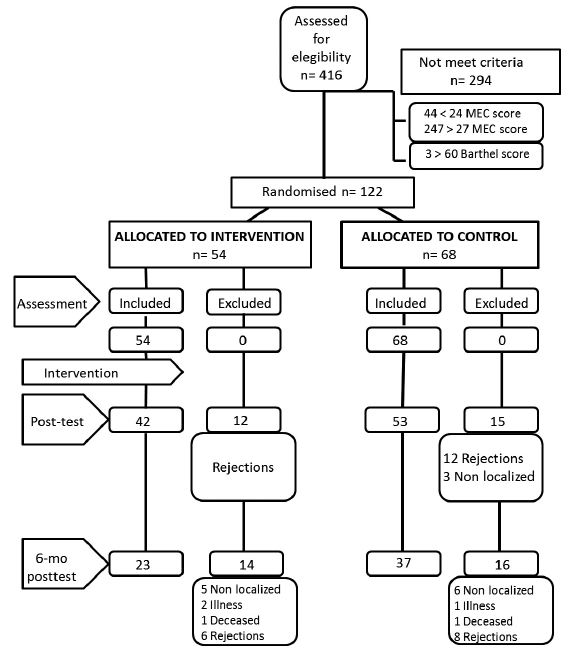
Figure 1. Flow chart of participation and study